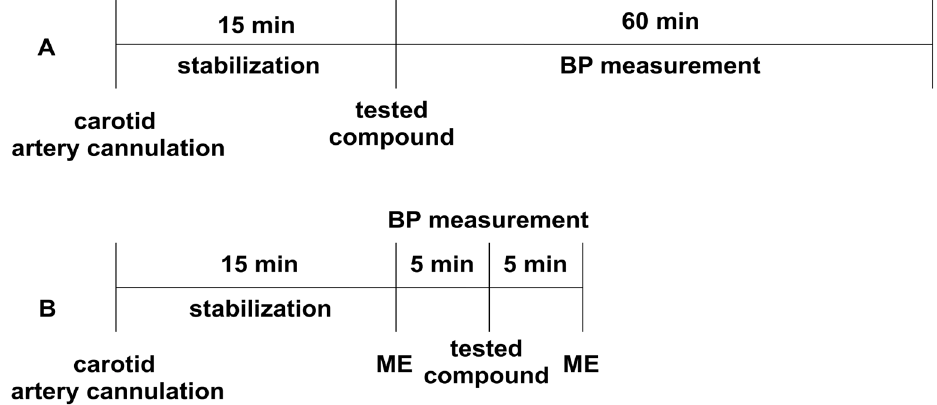
Figure 4. The experimental setup for studying the influence of the tested compounds on blood pressure (Panel A ), and the pressor response to methoxamine (Panel B ) in normotensive rats. All the compounds were administered intravenously ( iv ). ME—methoxamine (150 μ g/kg), BP—blood pressure.